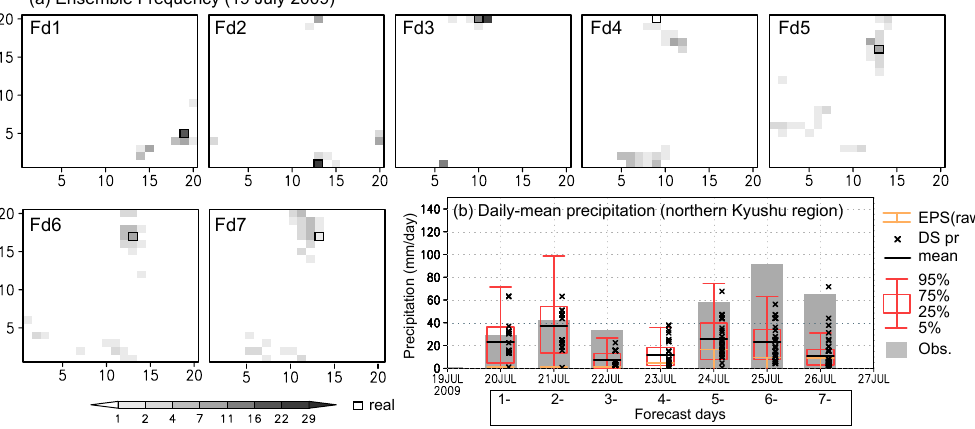
Figure 3. (a) SOM frequency (best matched) of the 51-ensemble members on the SOM lattice for the forecast day 1–7. Solid black box represents the actual state. (b) Daily-mean precipitation obtained from the downscaling for the forecast day 1–7. The spread of the ensemble for GSM raw is presented by orange box. The node-mean downscaled precipitation and its ensemble mean are represented by black × mark and horizontal bar, respectively. Composited PDFs of downscaled precipitation obtained from the SOM are represented by red error bar. Observational precipitation (actual state) is represented by the gray